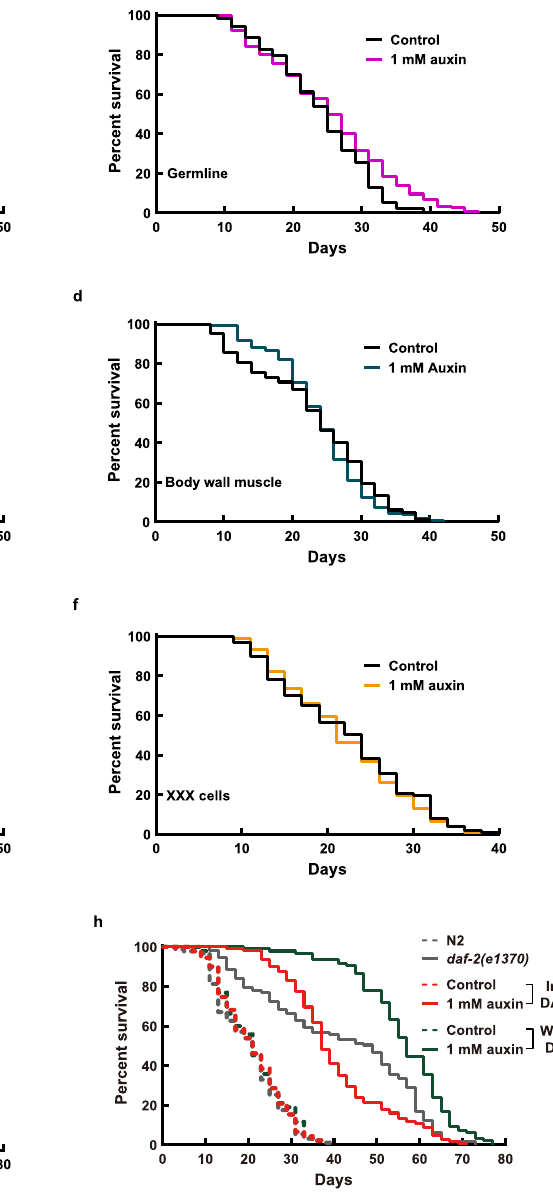
whole body increased WT lifespan by 166.5% (green solid line versus green dashed line, p <0.0001), which outlived the canonical hypomophic daf-2(e1370) mutant worms and the intestinal DAF-2 AID worms (gray solid line and red solid line, respectively). p values are calculated by log-rank tests. See survival statistics in Supplementary Data 1. Source data are provided as a Source Data fi